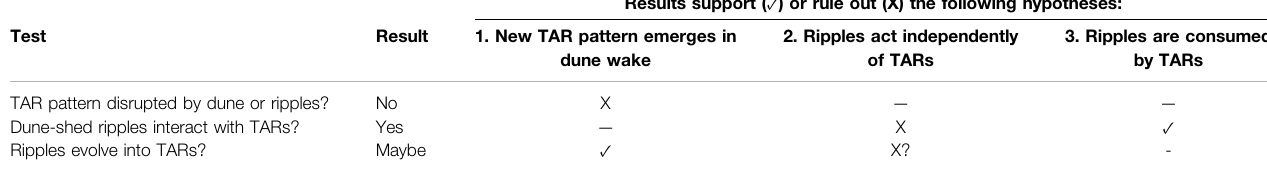
TABLE 5 | Results of testing the hypotheses of wake bedform pattern